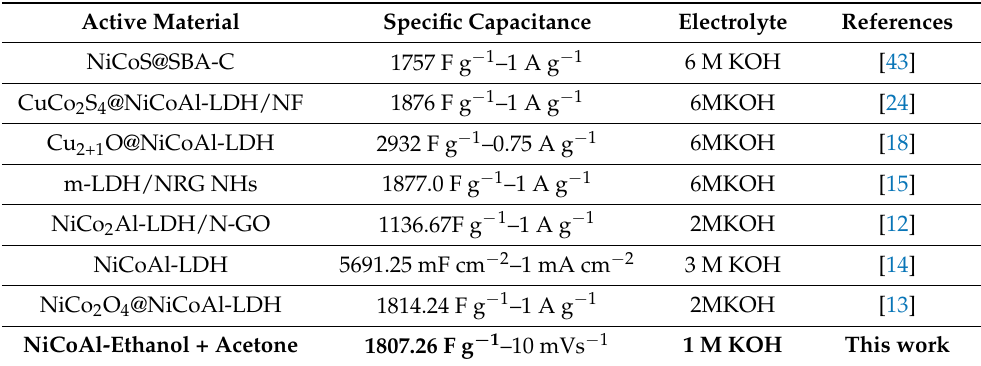
Table 6. Capacitance performance of various NiCoAL-LDH-based